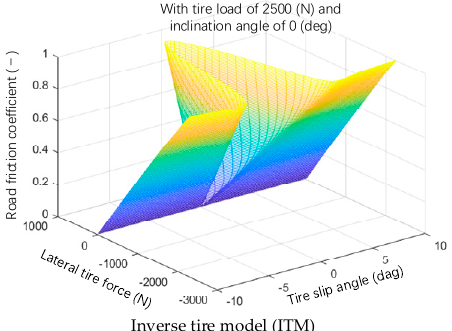
Figure 5. Map of the inverse tire model.